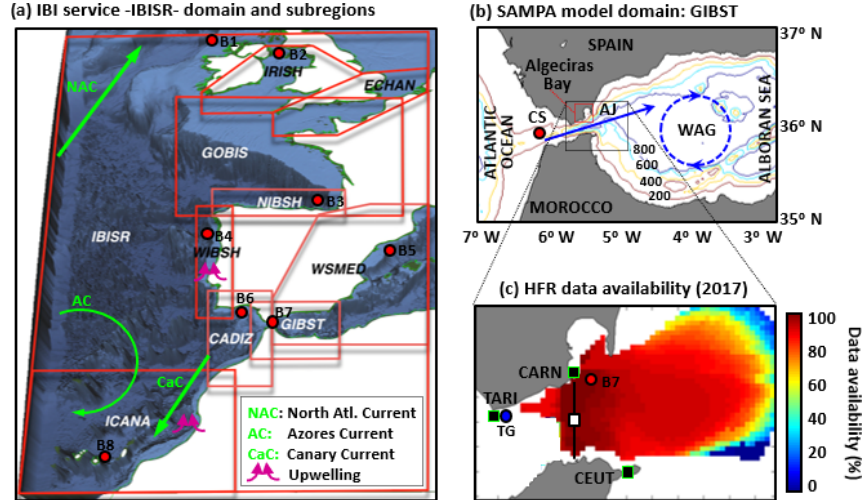
Figure 1. (a) Iberia–Biscay–Ireland service (IBISR) domain, which comprises nine subregions denoted by red squares. Filled red dots represent buoy locations. (b) Study area: coverage domain of SAMPA coastal ocean model, where the surface Atlantic Jet (AJ) flows through the Strait of Gibraltar into the Alboran Sea, feeding the Western Alboran Gyre (WAG); isobath depths are labelled every 200m. Red dots indicate a topographic feature: Camarinal Sill (CS). (c) HFR hourly data availability for 2017: solid black squares represent radar sites, blue and red dots indicate Tarifa tide gauge and B7 buoy location, respectively. The black line denotes the selected transect and the white square represents its